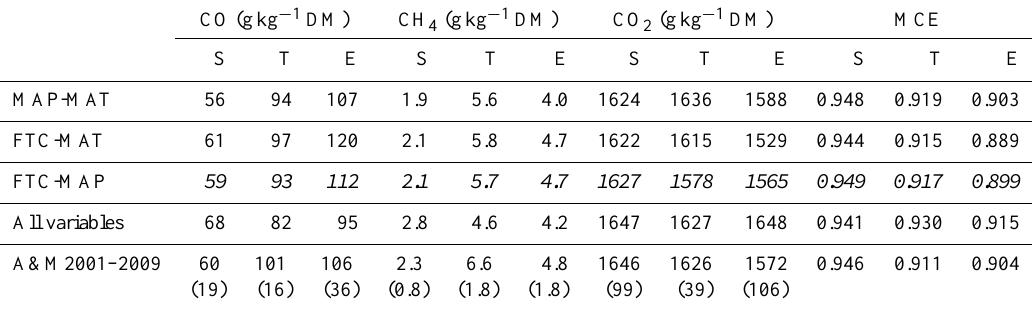
Table 2. EFs of CO, CH 4 , CO 2 (in gkg − 1 DM), and MCE for the savanna and grassland (S), tropical forest (T), and extratropical forest (E) biome, weighted by carbon emissions and stratified by mean annual precipitation (MAP), mean annual temperature (MAT), fraction tree cover (FTC) bins, and a multivariate regression equation that combined different environmental variables (All variables, See Table 1). Biome-averaged arithmetic means of A&M2001–2009 are also shown, with standard deviations in parenthesis. The results for the climatic window with the highest predictive power are shown in